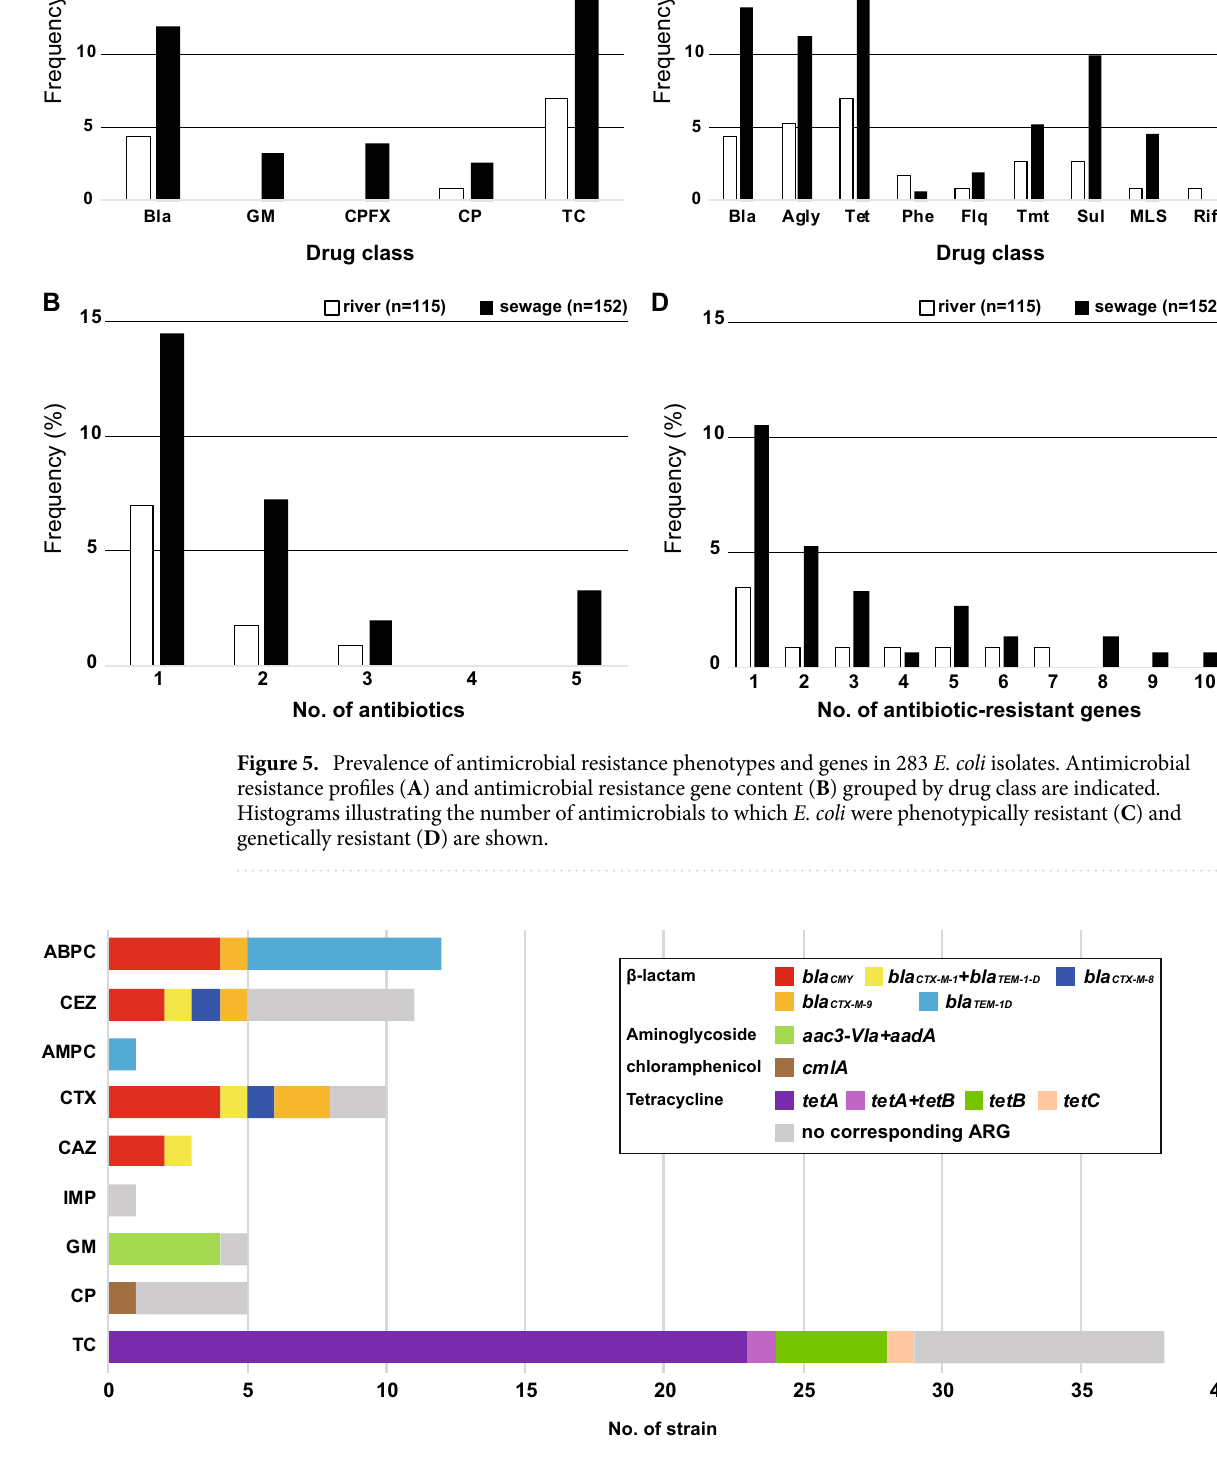
Figure 6. Concordance of phenotypic and genotypic antimicrobial resistance. In each drug class, the numbers of phenotypically resistant strains with or without corresponding antibiotic resistance genes (ARGs) are